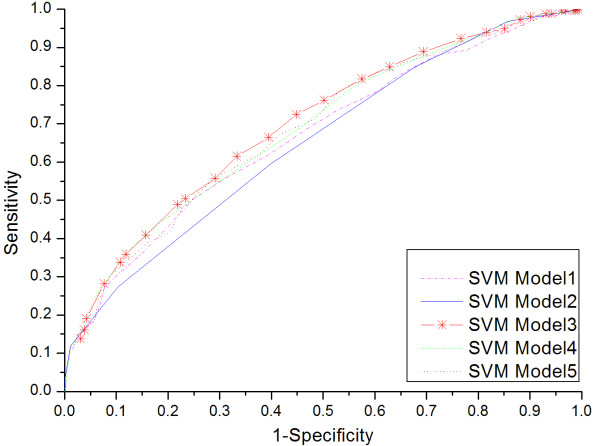
ROC Curves of five different SVM models. A ROC curve provides a graphical representation of the relationship between the true-positive and false-positive prediction rate of a SVM model. ROC curve is obtained by plotting all 1-Specificity values (false-positive rate) on the X axis and Sensitivity (true-positive rate) on the Y axis. The resulting area under the ROC curve is an important index for evaluating the classification performance, i.e. the highest and leftmost ROC curve in the plot represents the best SVM model.